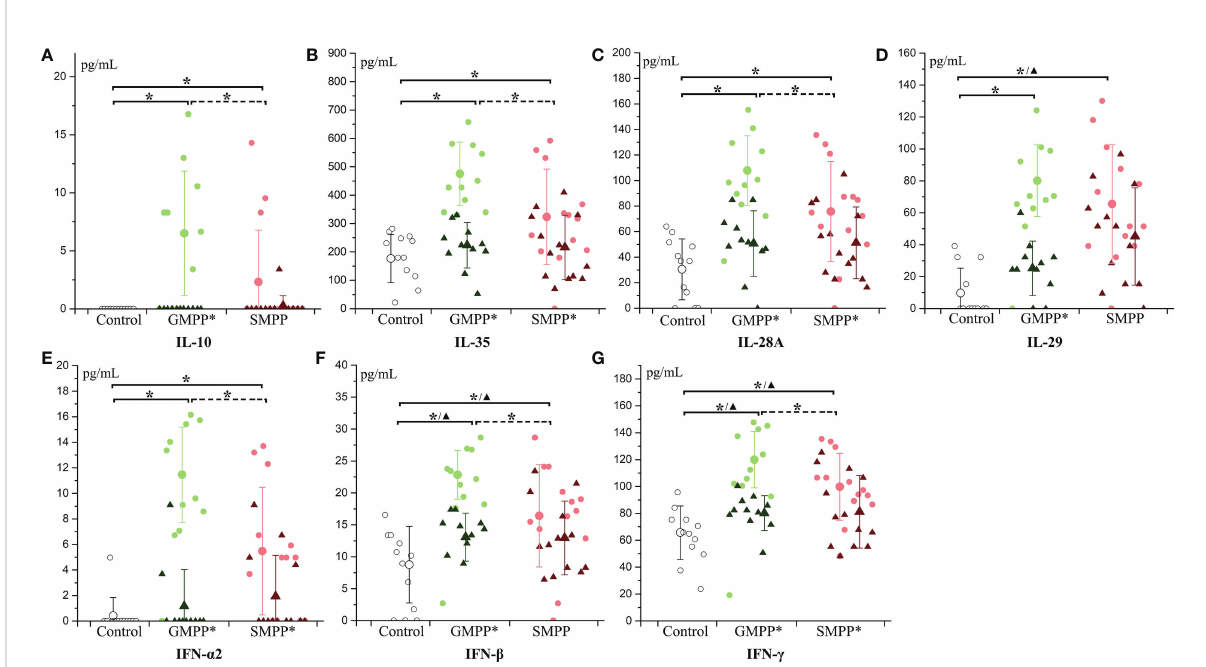
FIGURE 5 The level of immunoregulation cytokines and interferon: (A) IL-10; (B) IL-35; (C) IL-28A; (D) IL-29; (E) IFN- a 2; (F) IFN- b ; (G) IFN- g . Indications of groups and symbols are the same as described in Figure